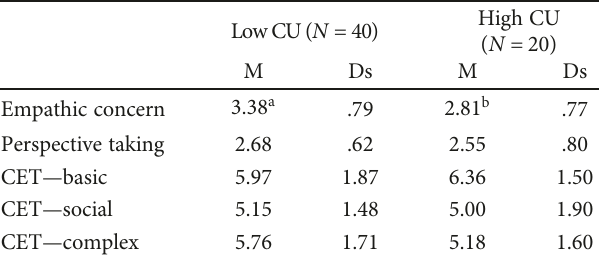
Table 2: Empathic, emotional, and behavioral pro fi les of the CU